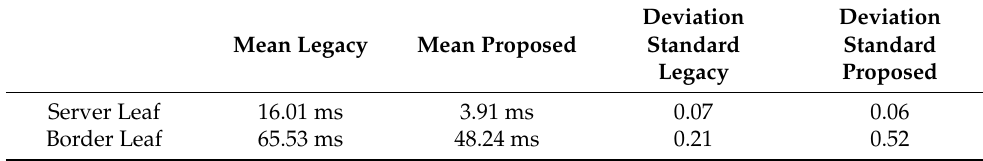
Table 6. Legacy vs. proposed latency comparison table.